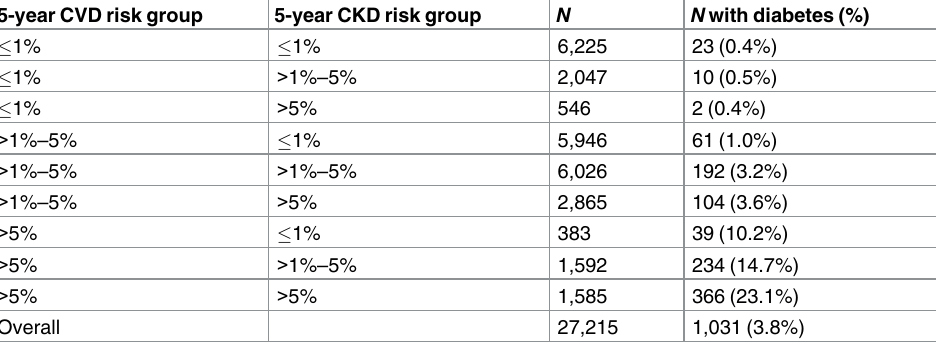
CKD, chronic kidney disease; CVD, cardiovascular